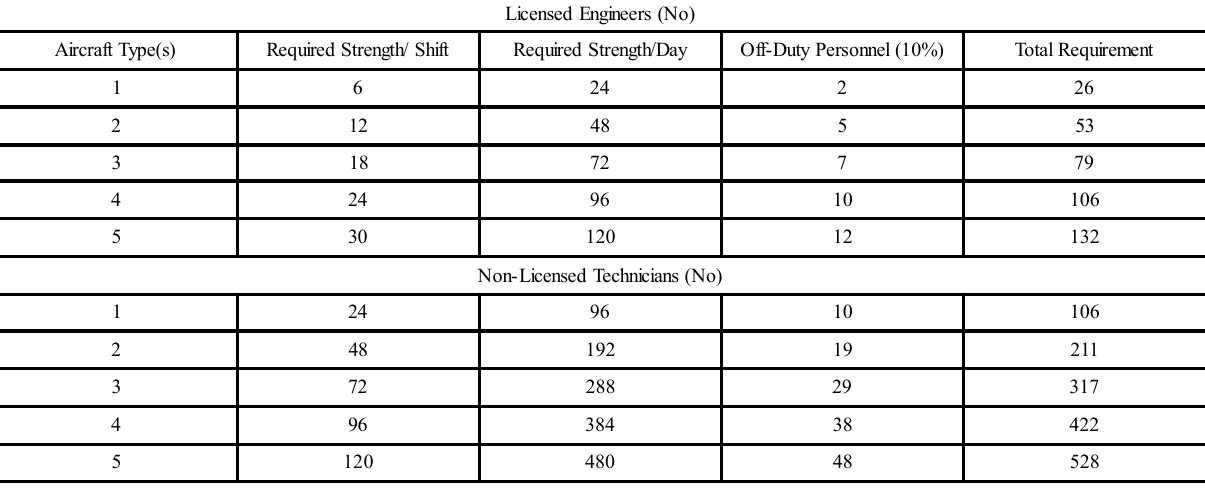
TABLE 1. TECHNICAL HR CADRES VS AIRCRAFT TYPES IN EXISTING